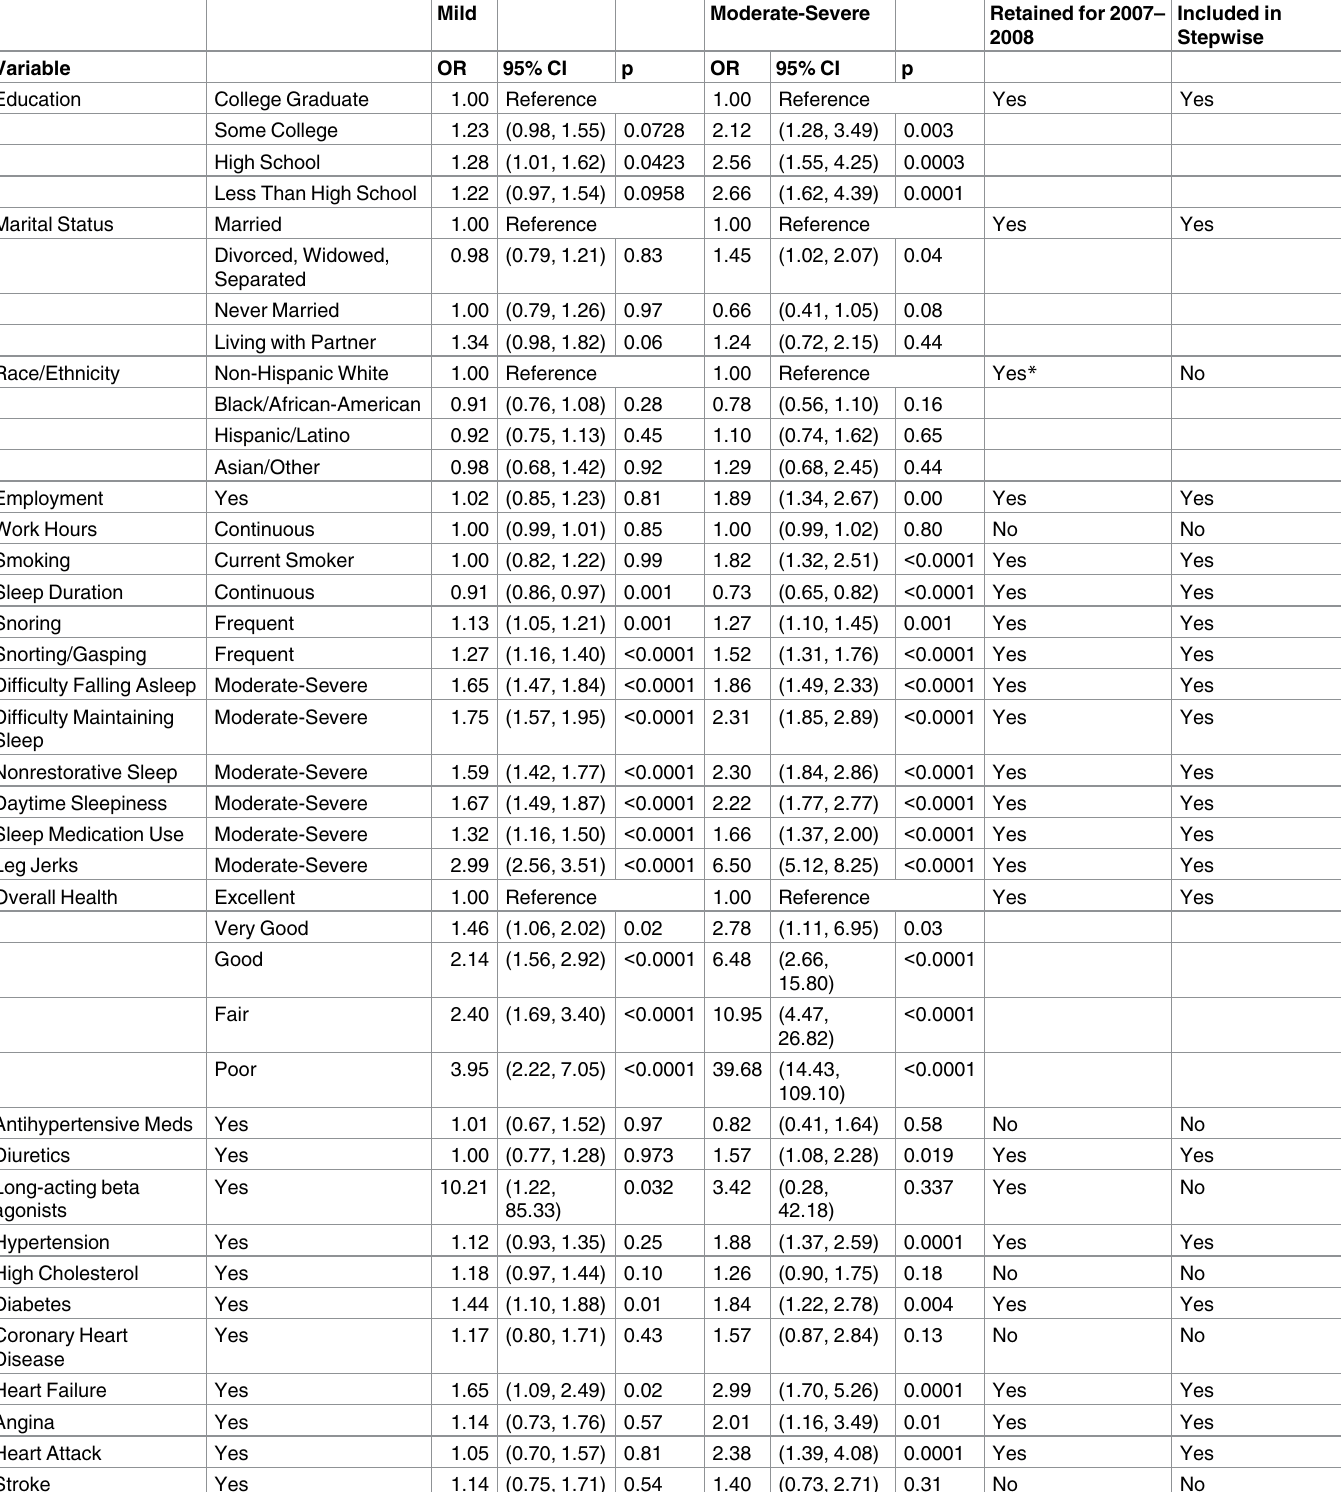
Table 2. Relationships between nocturnal leg cramps and variables in the 2005–2006 wave, adjusted for age and sex. Mild Moderate-Severe Retained for 2007–